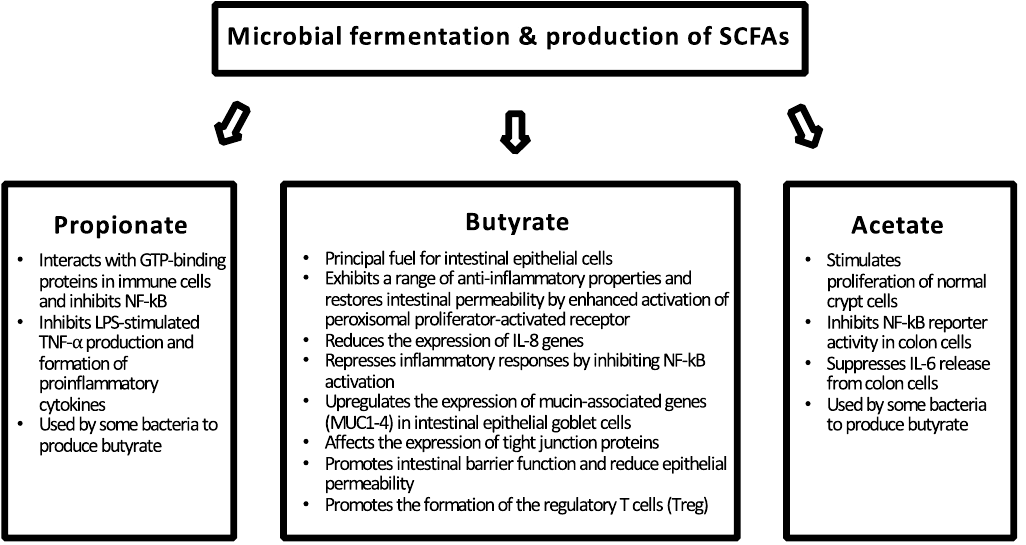
Figure 2. The major short-chain fatty acids (SCFAs) produced by gut microbiota and their health- promoting effects on the gut epithelium [54,55].